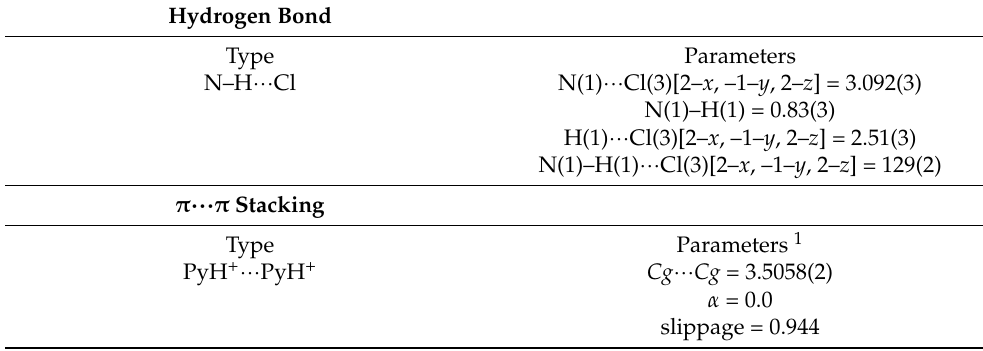
Table 2. Intermolecular interactions [Å, ◦ ] in (PyH) 2 [MoOCl 5